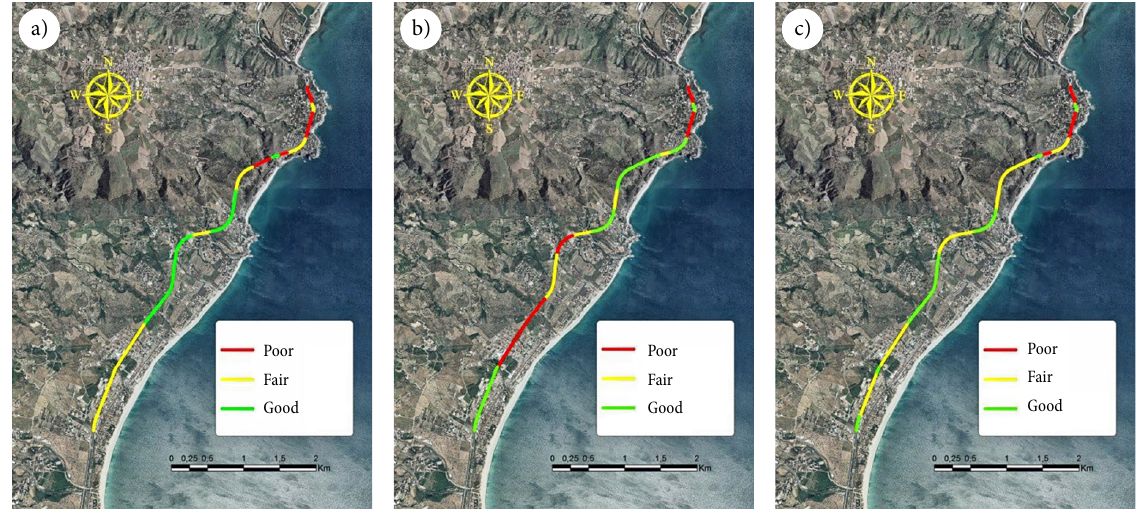
Fig. 3. Design consistency evaluation according to Lamm’s safety criterion I